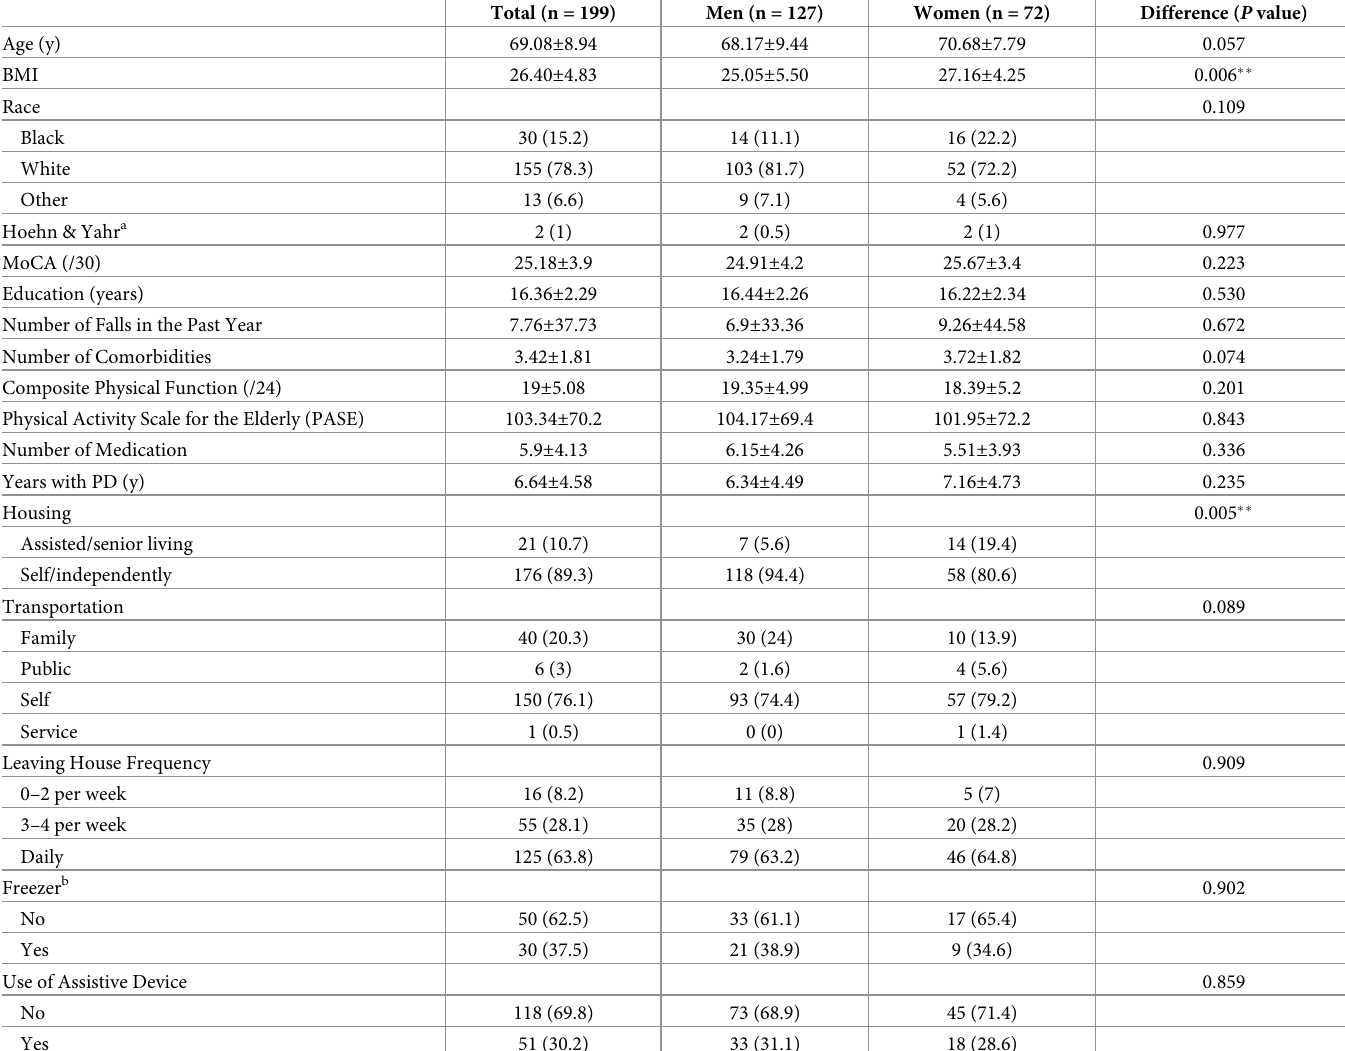
Table 1. Participants’ demographics and clinical